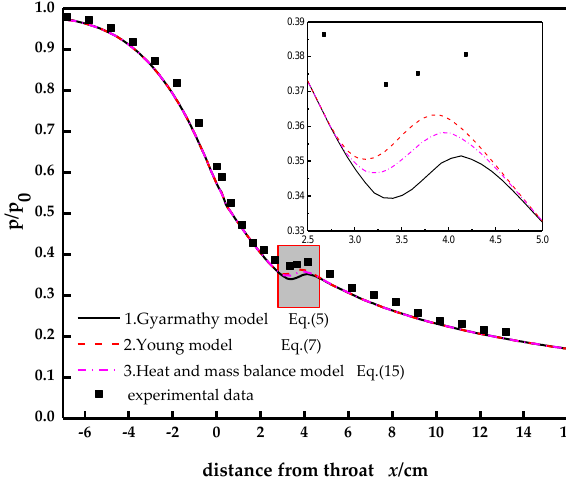
Figure 7. Pressure ratio along the nozzle axis compared with experimental data.